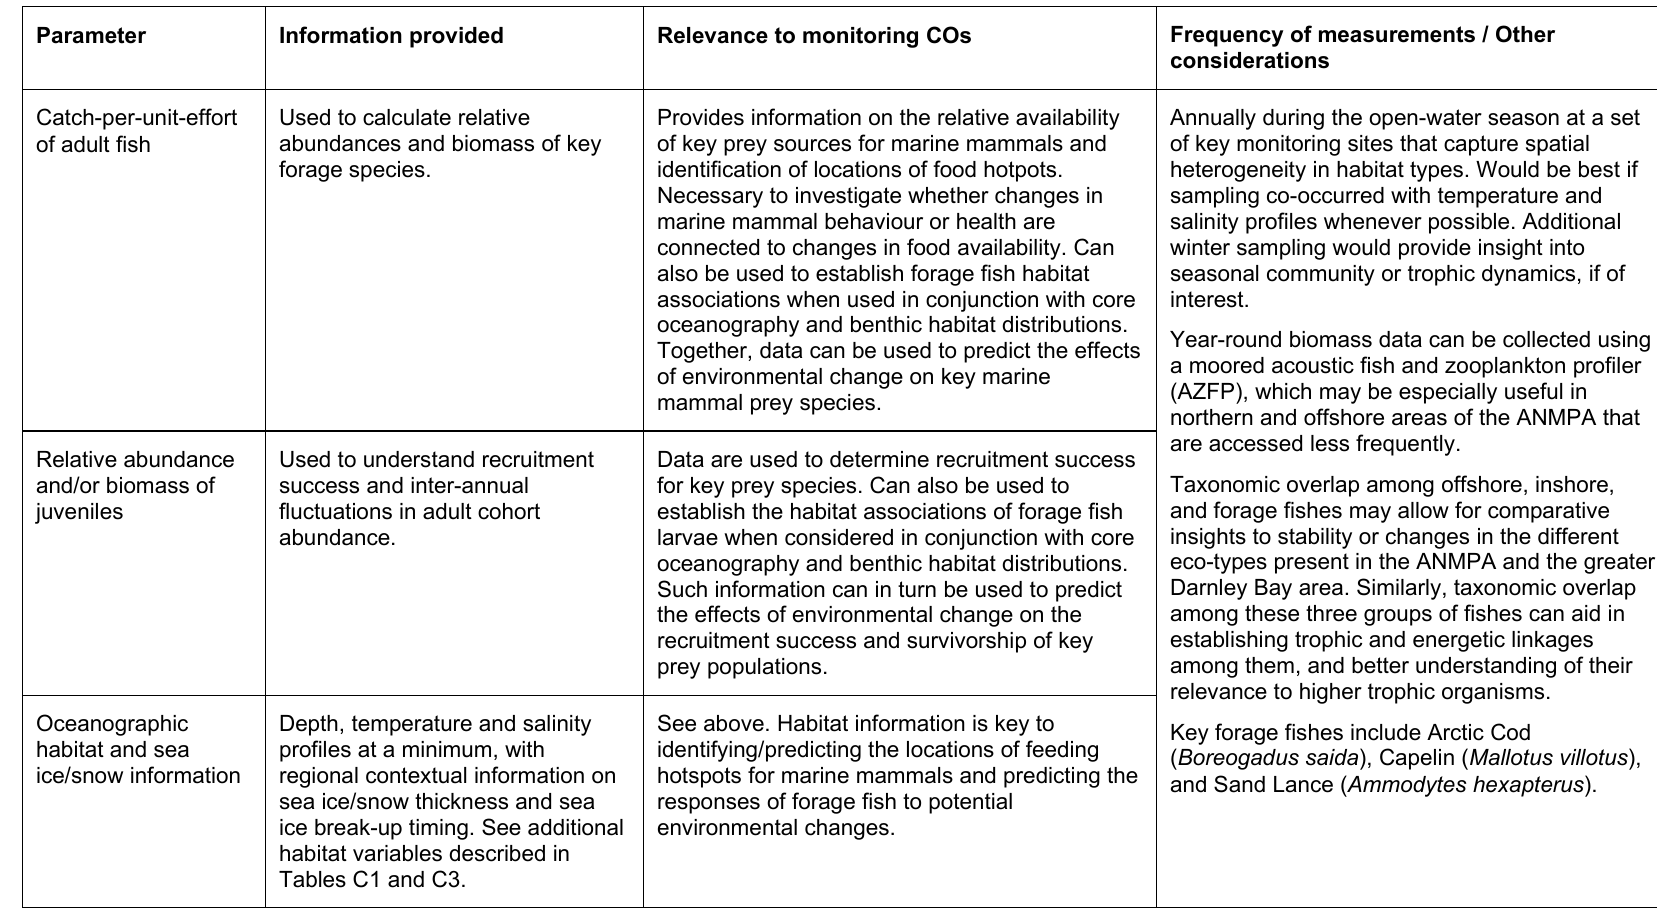
Table C6.7. Key measurement parameters for monitoring forage fish relative abundance and biomass (Section